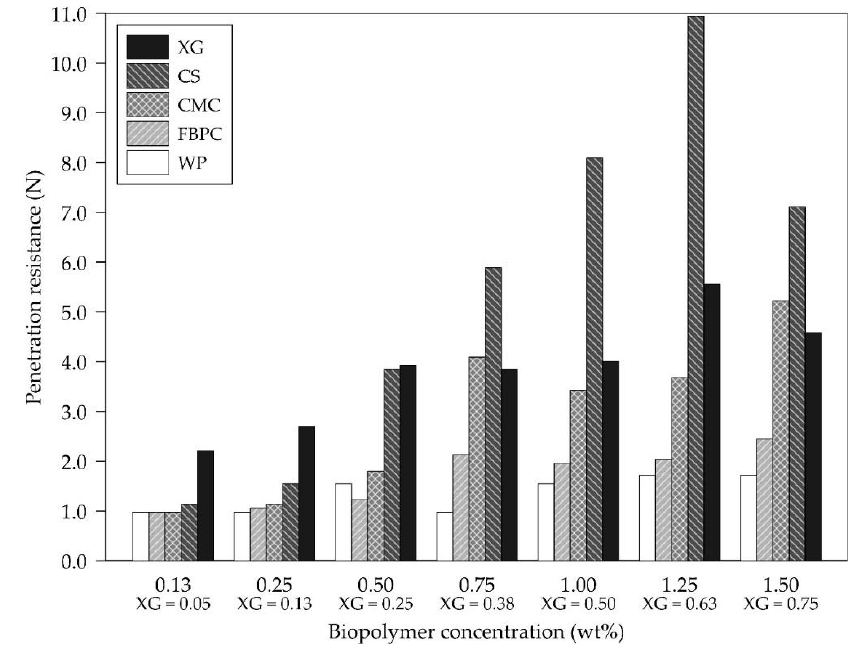
Figure 8. Penetration resistance of crusts after last wind tunnel test on day 28 on medium-grained sand. Penetration resistance tests were performed with six replicates (n = 6) with two penetrations per sample. The numerical data (mean (M) and standard deviation (SD)) are appended in Table A4. Fine-grained silica sand . Figure 9 shows the results of pocket penetrometer tests per- formed on fine-grained silica sand after the fifth wind tunnel cycle. Similar to the medium- grained sand, the control group exhibited no measurable penetration resistance, while all the biopolymer treatments formed crusts, with the penetration resistance tending to increase at higher concentrations. The polysaccharide treatments (XG, CMC, and CS) and FBPC). XG formed relatively strong crusts at the lower tested concentrations and is only surpassed by CMC and CS at concentrations ≥ 0.75 wt% (XG ≥ 0.38 wt%). The resistance of WP- and FBPC-treated samples plateaued at concentrations of 0.50 and 0.75 wt%, respectively. In contrast, XG- and CMC-treated samples peaked at 0.63 and 1.50 wt%, respectively, after stagnating at lower concentrations.